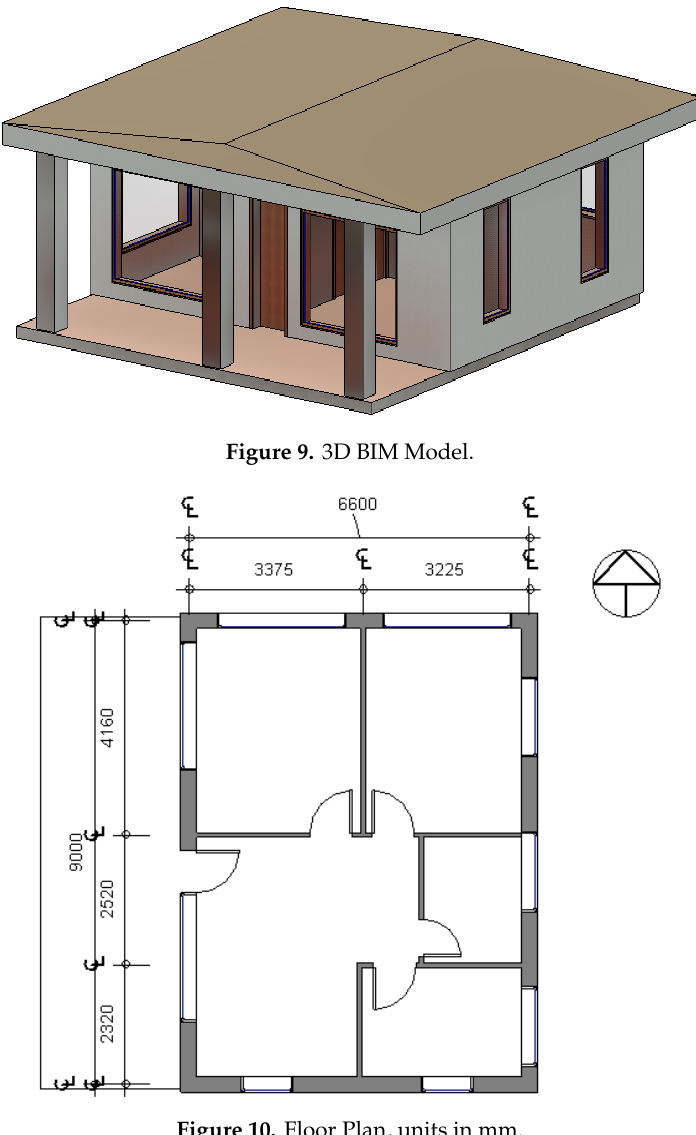
Figure 10. Floor Plan, units in mm.